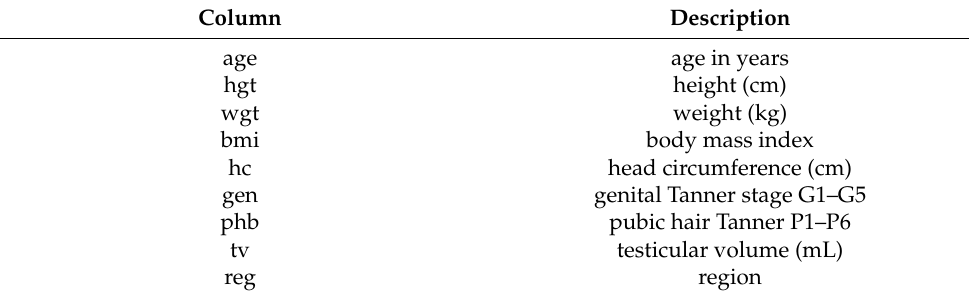
Table 1. Description of the features in the mice::boys data set. Column